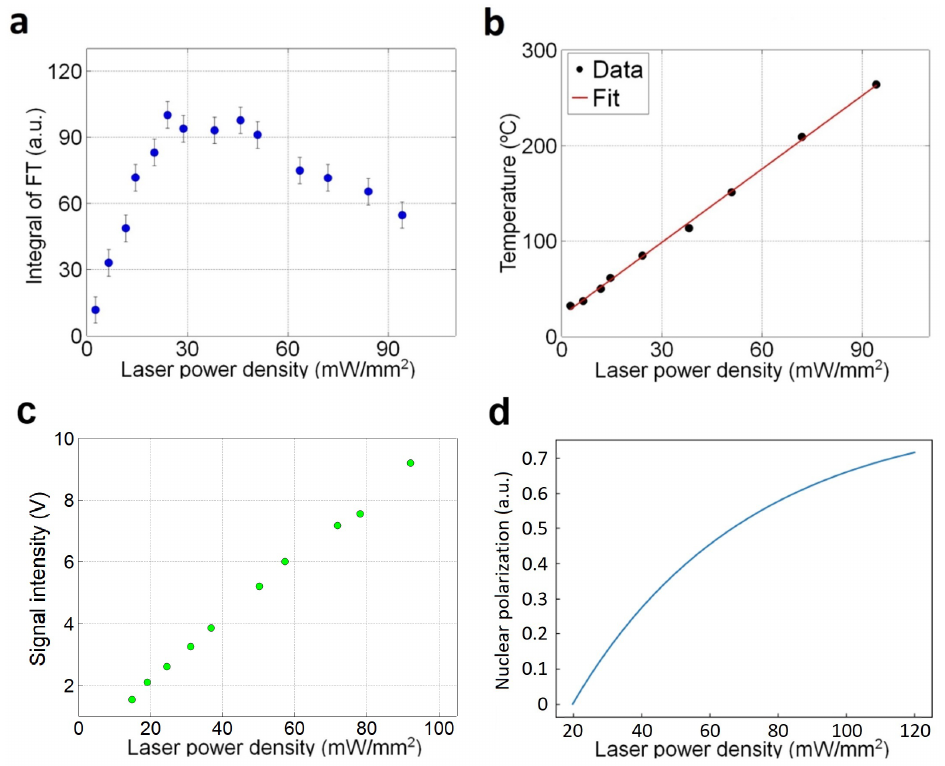
Figure 4. ( a ) The (normalized) 13 C polarization obtained through optical DNP is measured as a function of laser power density. ( b ) The variation of diamond’s temperature with increasing the laser power density. ( c ) Fluorescence intensity of NV centers in diamond increases linearly with the laser power density. ( d ) The curve of the 13 C polarization expected by using the results in Figure